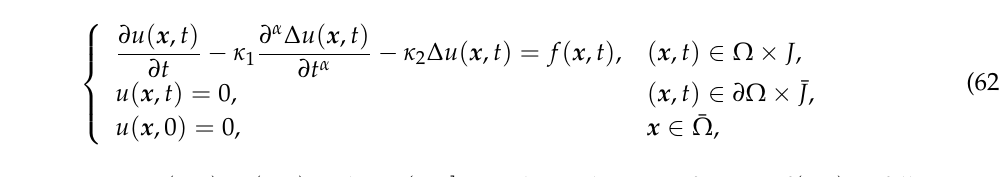
Table 1. Error max